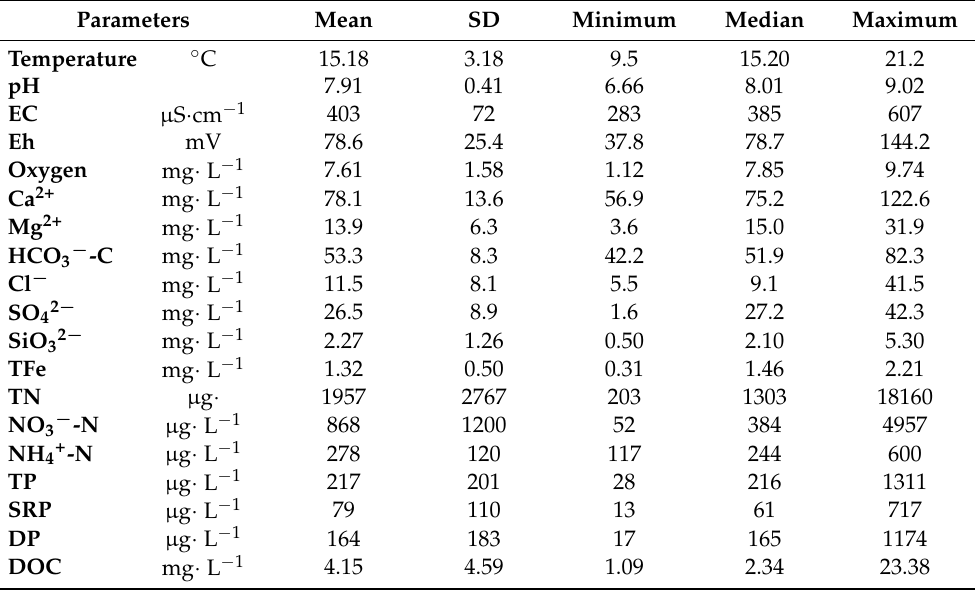
Table 2. Summary statistics for spring water chemistry (EC—electrical conductivity, Eh—water redox potential, TFe—total iron, TN—total nitrogen, TP—total phosphorus, SRP—soluble reactive phosphorus, DP—dissolved phosphorus, DOC—dissolved organic